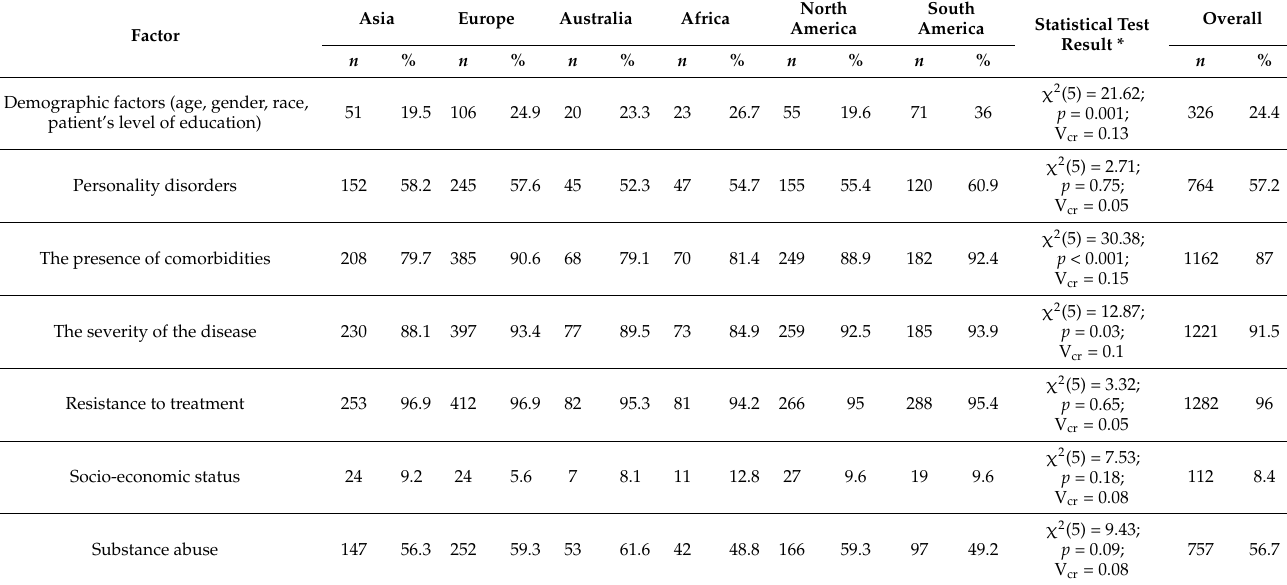
Table 10. Psychiatrists’ answers on the factors influencing the occurrence of the phenomenon of